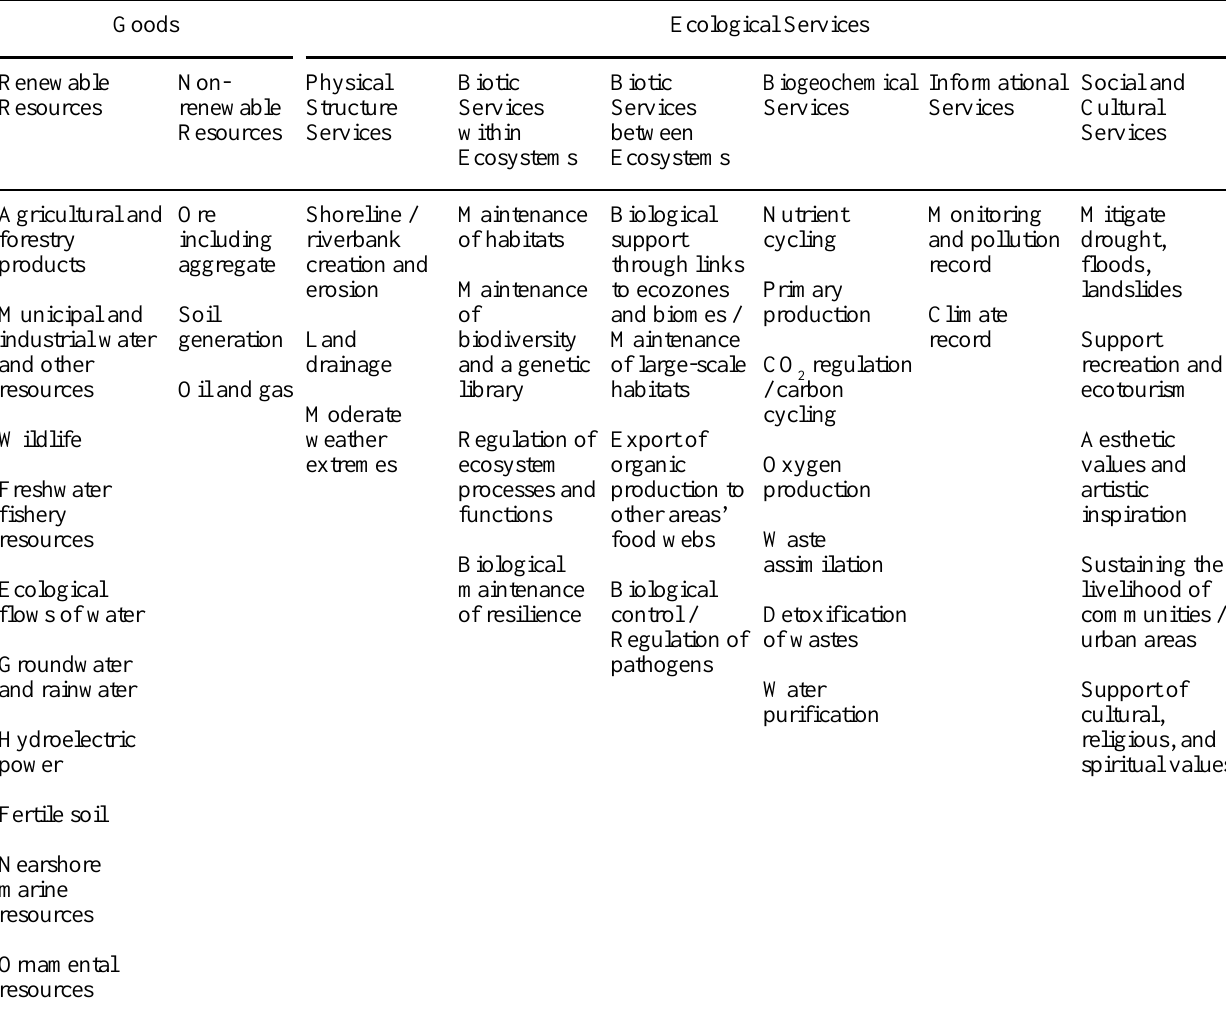
Table 1. Overview of ecological goods and services provided within watersheds (Parkes et al. (2008) after the matrix presented by Moberg and Folke (1999) for coral